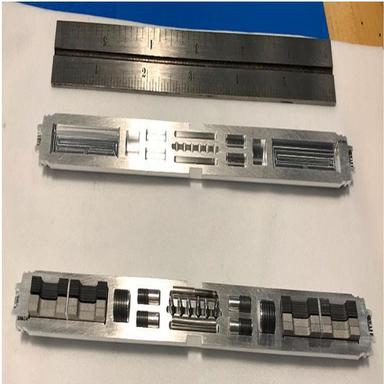
Photograph of the SAM-2 experiment fixture assembly.